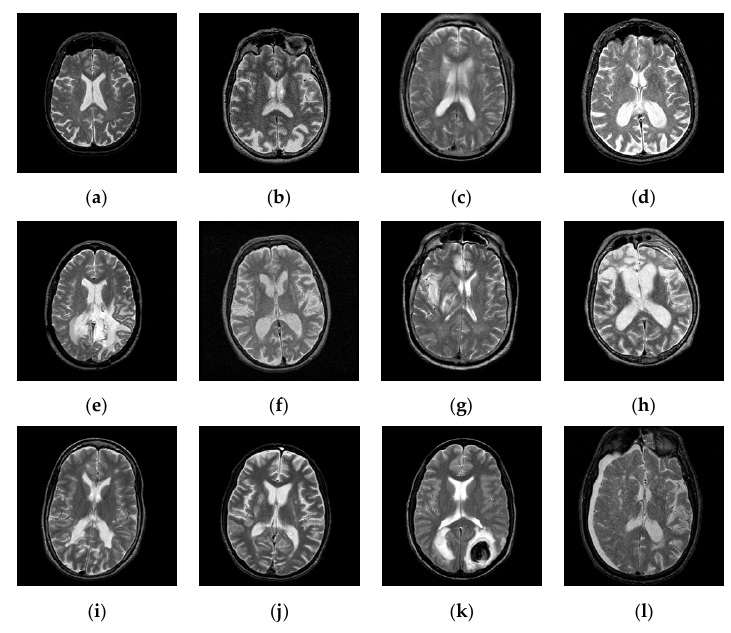
Figure 1. Sample of pathological brains. ( a ) Normal brain; ( b ) Alzheimer’s disease (AD) with visual agnosia; ( c ) Meningioma; ( d ) AD; ( e ) Glioma; ( f ) Huntington’s disease; ( g ) Herpes encephalitis; ( h ) Pick’s disease; ( i ) Multiple sclerosis; ( j ) Cerebral toxoplasmosis; ( k ) Sarcoma; ( l ) Subdural hematoma.